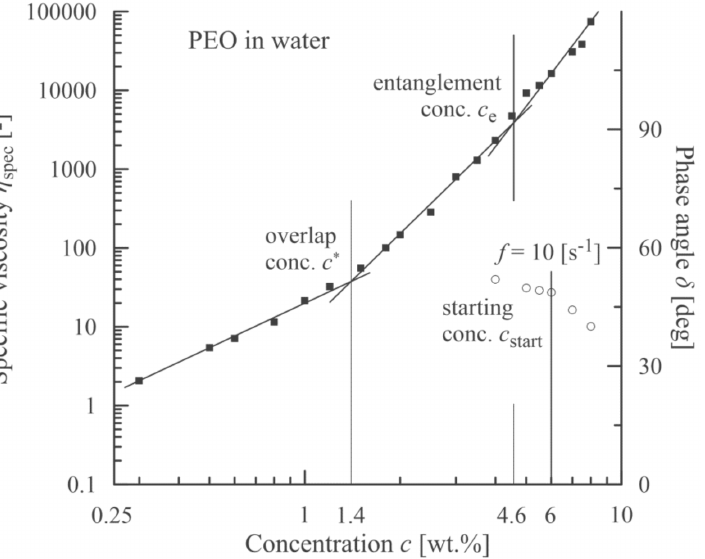
Figure 6. Correlation between a sudden decrease in phase angle (open circles) and a starting concentration corresponding to an onset of beadless PEO